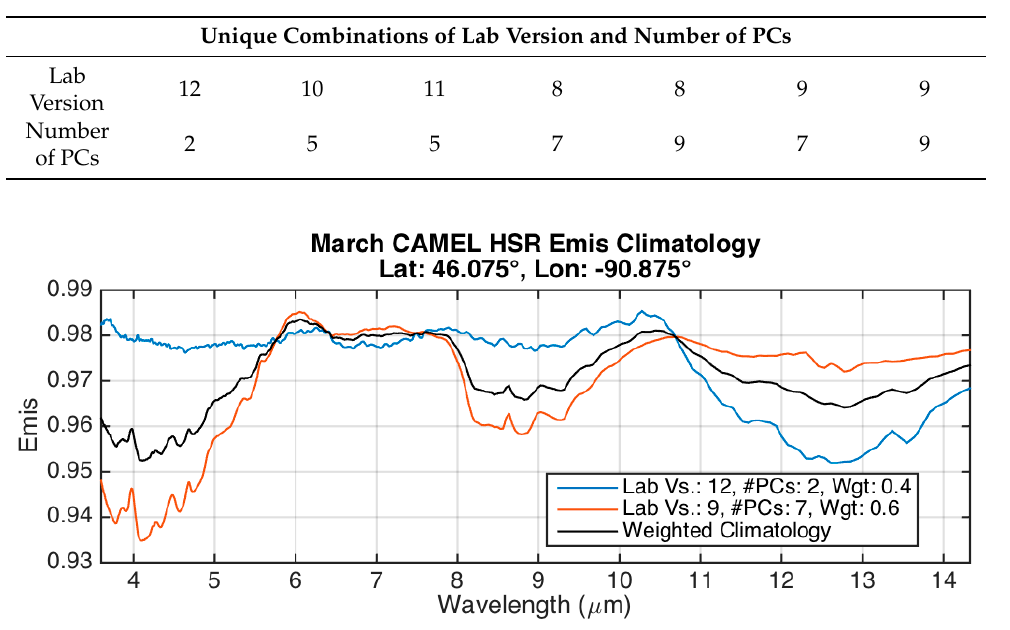
Table 2. Unique combinations of the CAMEL lab dataset version and number of principal components (PCs) used to construct the high spectral resolution emissivity.